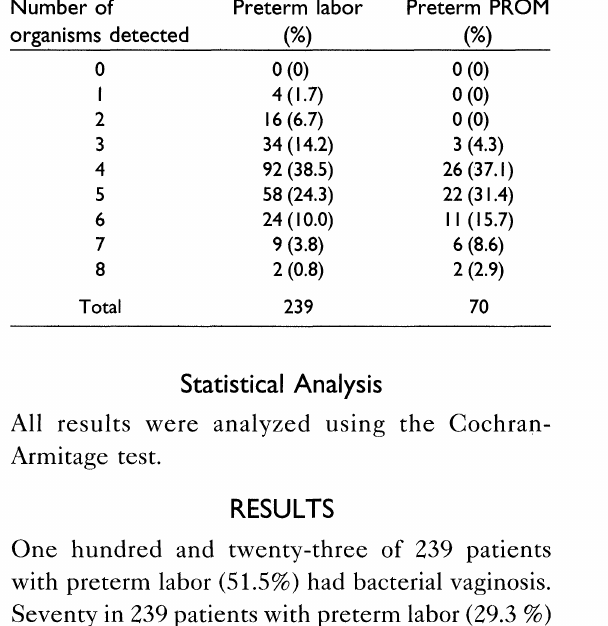
TABLE I. The number of different species detected in all patients with preterm labor and those who developed preterm PROM Number of Preterm labor Preterm PROM